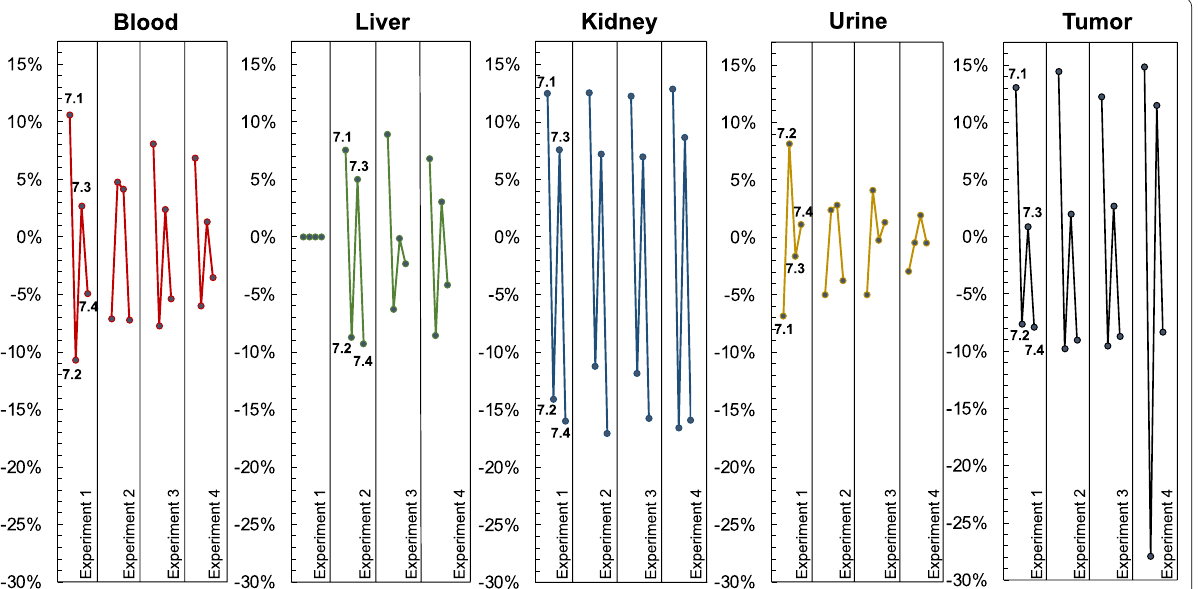
Fig. 5 Differential uptake and excretion pattern: relative percentage difference between the abundance of [ 18 F, nat Ga]rhPSMA‑7.1 to ‑7.4 in blood, liver, kidney, urine and tumor of male LNCaP tumor‑bearing SCID mice (30 min p.i.) compared with the respective abundance found in the quality control of diastereomeric mixture [ 18 F, nat Ga]rhPSMA‑7. n 4 in four independent experiment; the liver from the first experiment was not analyzed = (see also Additional file 1: Fig.